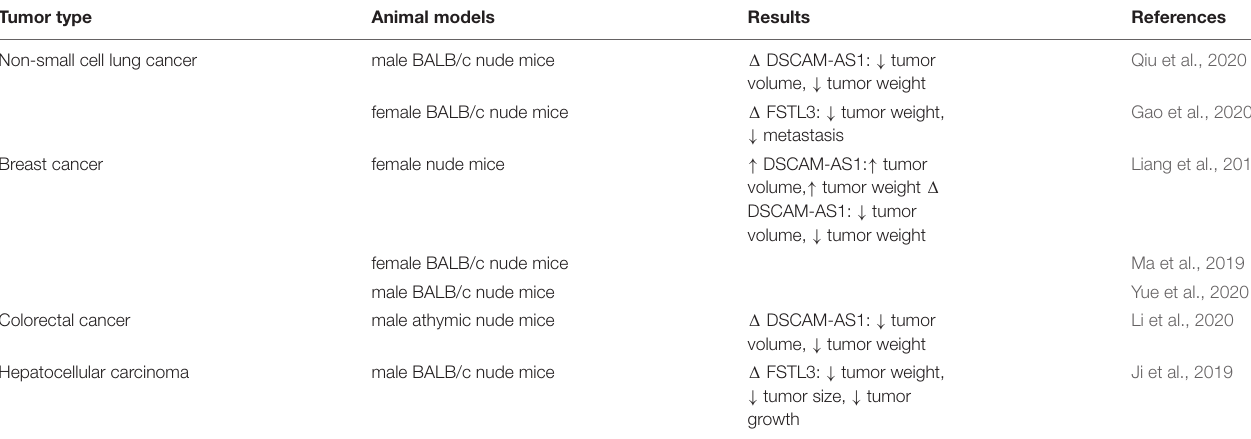
TABLE 2 | Results of studies which evaluated function of DSCAM-AS1 in animal models ( (cid:49) : knock-down or deletion). Tumor type Animal